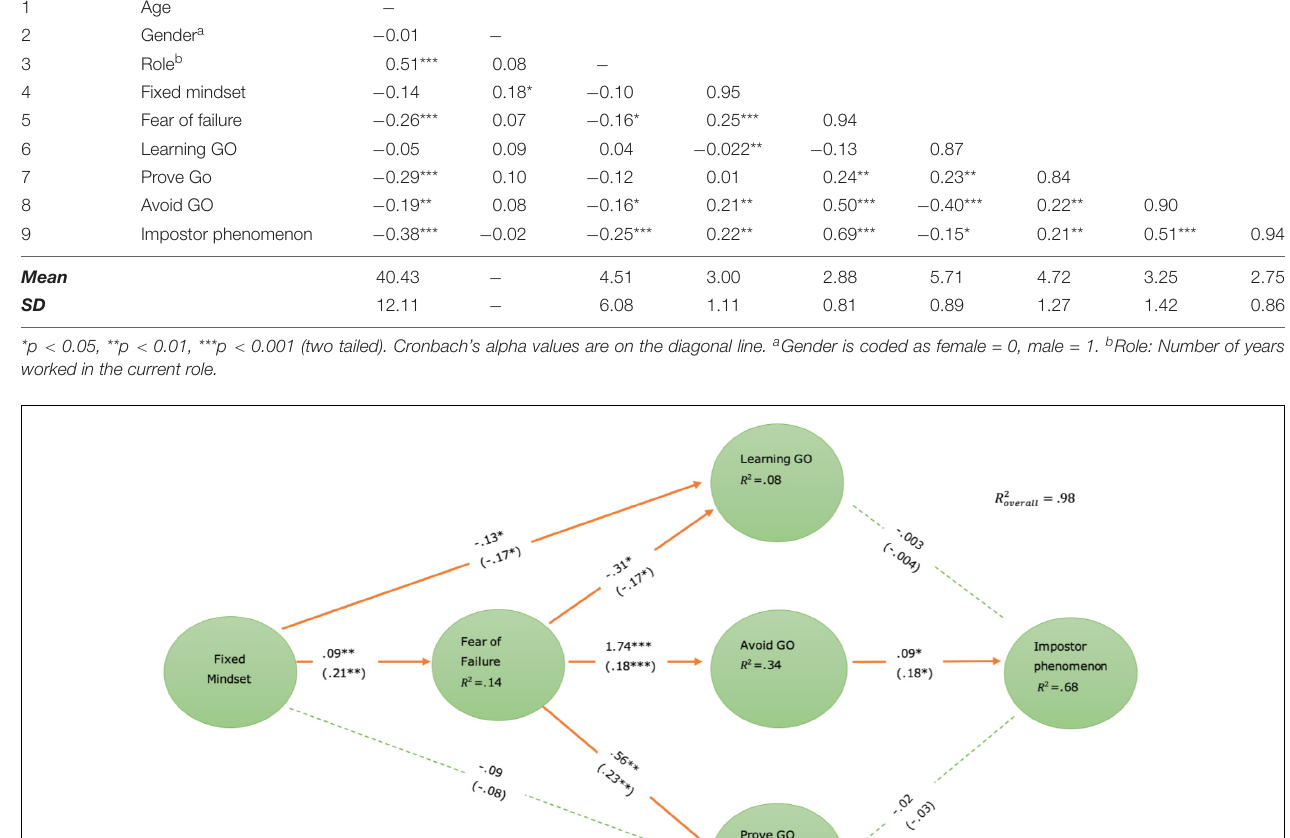
( β = 0.17, p = 0.007). We further deconstructed this serial- parallel mediation mechanism into seven indirect paths using PROCESS v3.5 with 5000 bootstrapping method (Hayes,